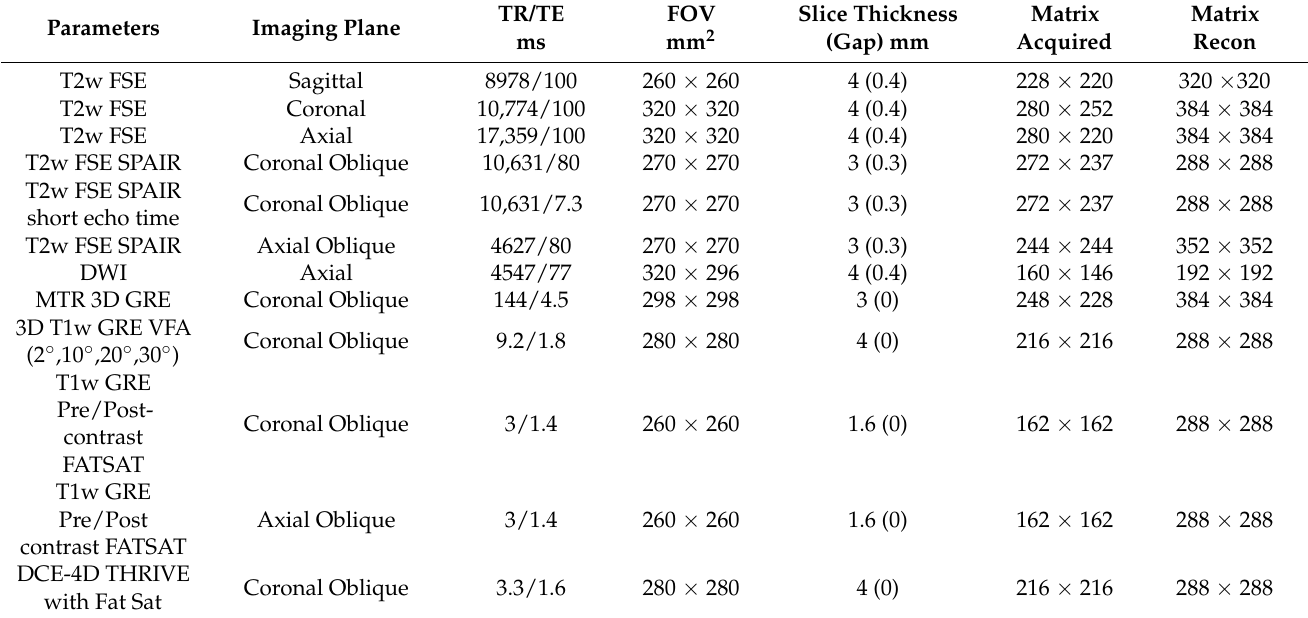
Table A4. MRI sequence parameter information for 3.0 T Philips scanner (Manchester